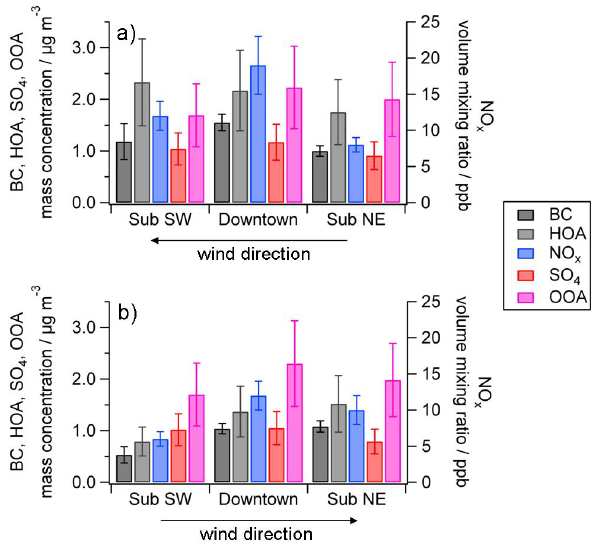
Fig. 12. Average mass concentrations (BC, HOA, SO 4 , OOA) and volume mixing ratios (NO x ) measured at the three stationary sites during “Atlantic Polluted” air masses for quasi-Lagrangian mea- surements at connected flow conditions with (a) Sub SW down- wind, (b) Sub NE downwind of the city centre. Error bars represent the associated estimated uncertainties for intercomparison purposes (see Sect. 2). The arrows indicate the wind direction of the con- nected flow during the measurement periods. The exact values and additional data from NO 3 and O 3 are given in Table 5.